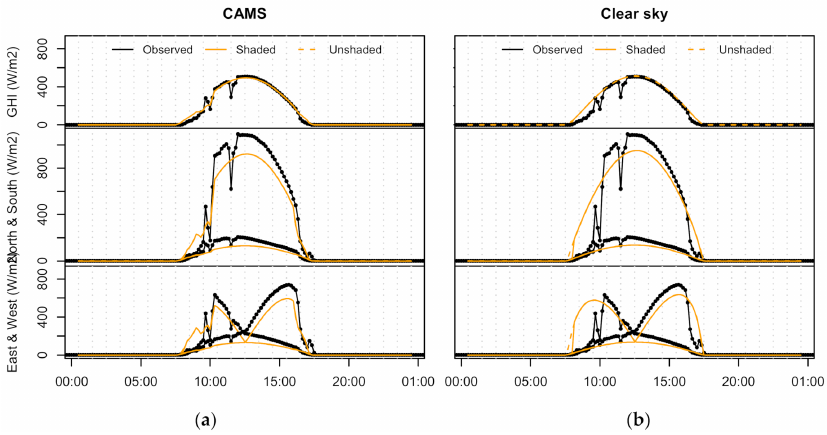
Figure 14. Observed global horizontal (GHI) and total vertical irradiance measured in each direction for a sunny day in winter at the Holzkirchen site compared to the calculated surface irradiances using the ( a ) CAMS radiation service as input. The ( b ) clear sky data are based on the CAMS-Rad McClear